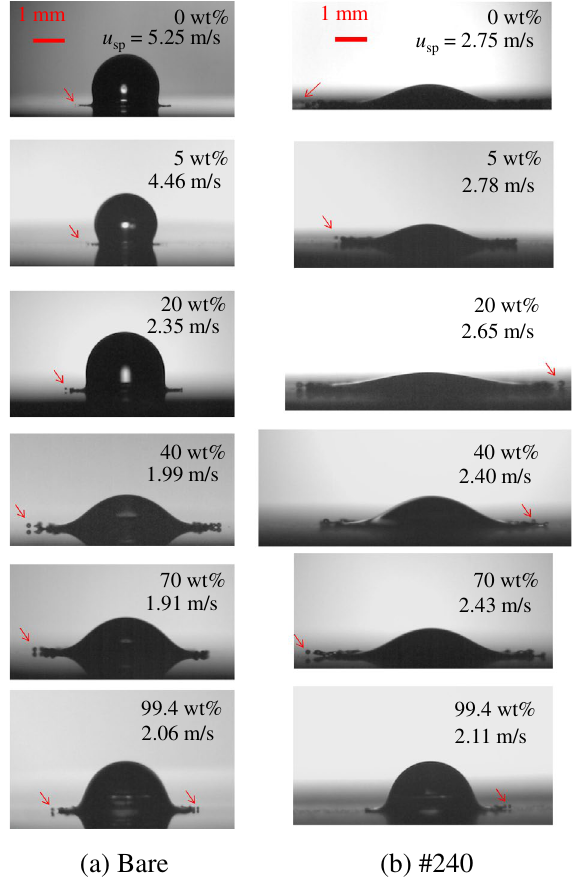
Figure 3. Splashing images of water–ethanol binary-mixture droplets on (a) bare (smooth solid surface) and (b) #240 PC substrates. The red arrows indicate the ejected secondary droplets. The droplet volumes for each liquid are 4.5 µL for 0 wt.%, 3.4 µL for 5 wt.%, 6.6 µL for 20 wt.%, 5.3 µL for 40 wt.%, 5.3 µL for 70 wt.% and 4.9 µL for 99.4 wt.%.